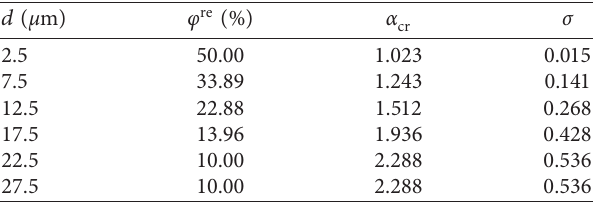
Table 11: Parameter values for LN distribution.